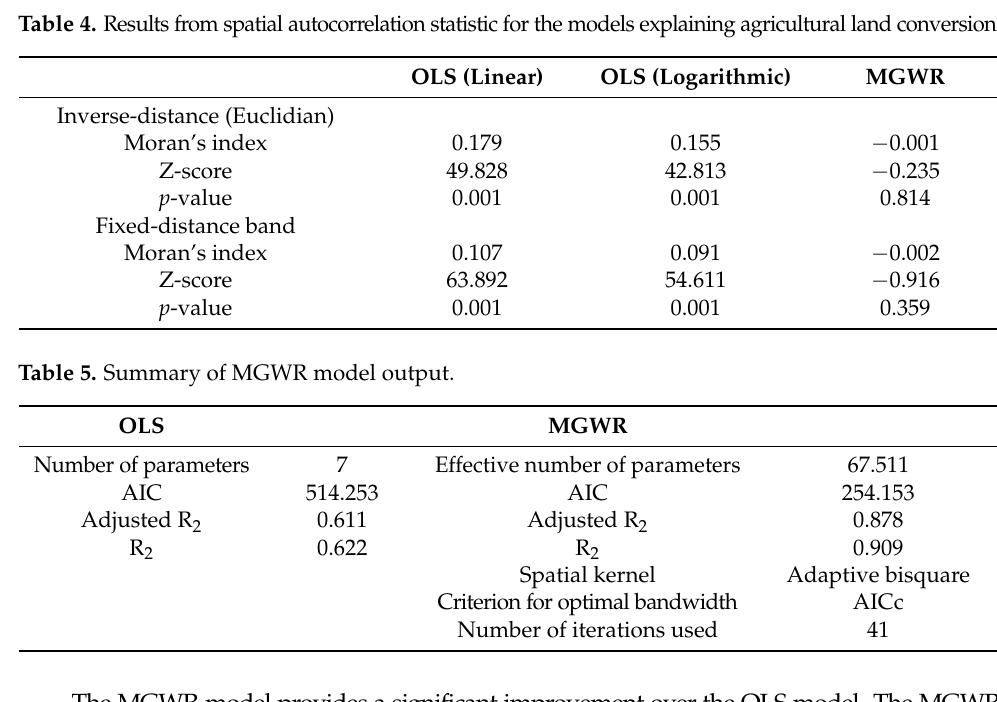
Table 5. Summary of MGWR model output. OLS